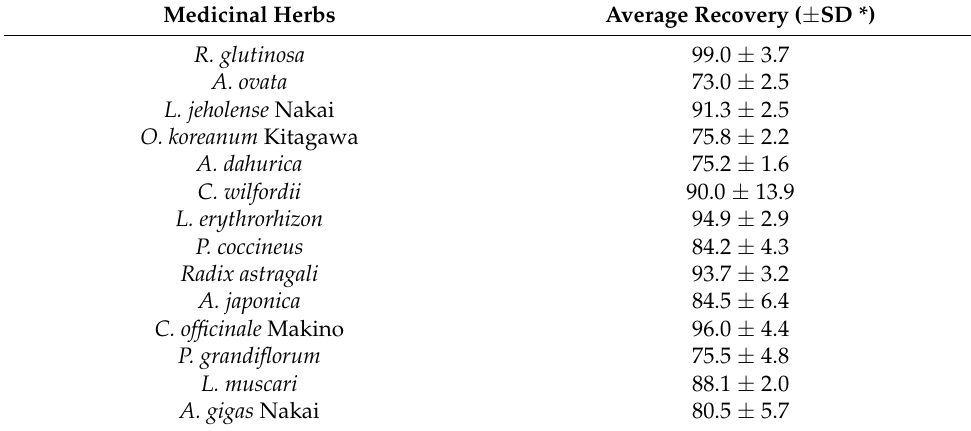
Table 3. Recovery (%) of indoxacarb in 14 medicinal herbs analyzed by LC–MS/MS. Medicinal